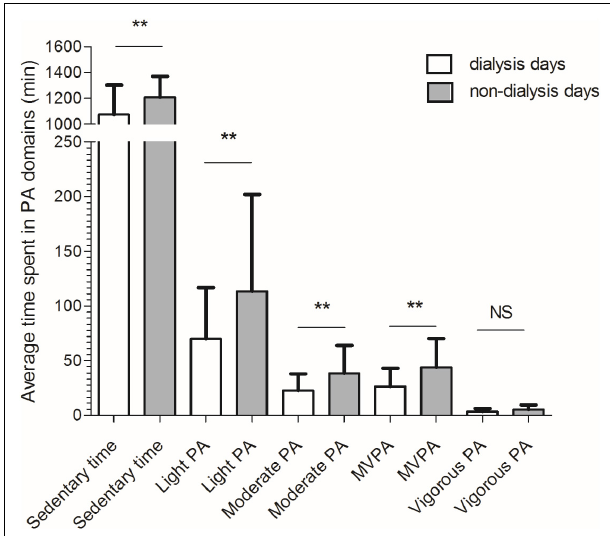
FIGURE 2 | Comparisons between dialysis (white bar) and non-dialysis (gray bar) for time spent in different physical activity domains. PA, physical activity; ** p < 0.01; NS, non-significant.